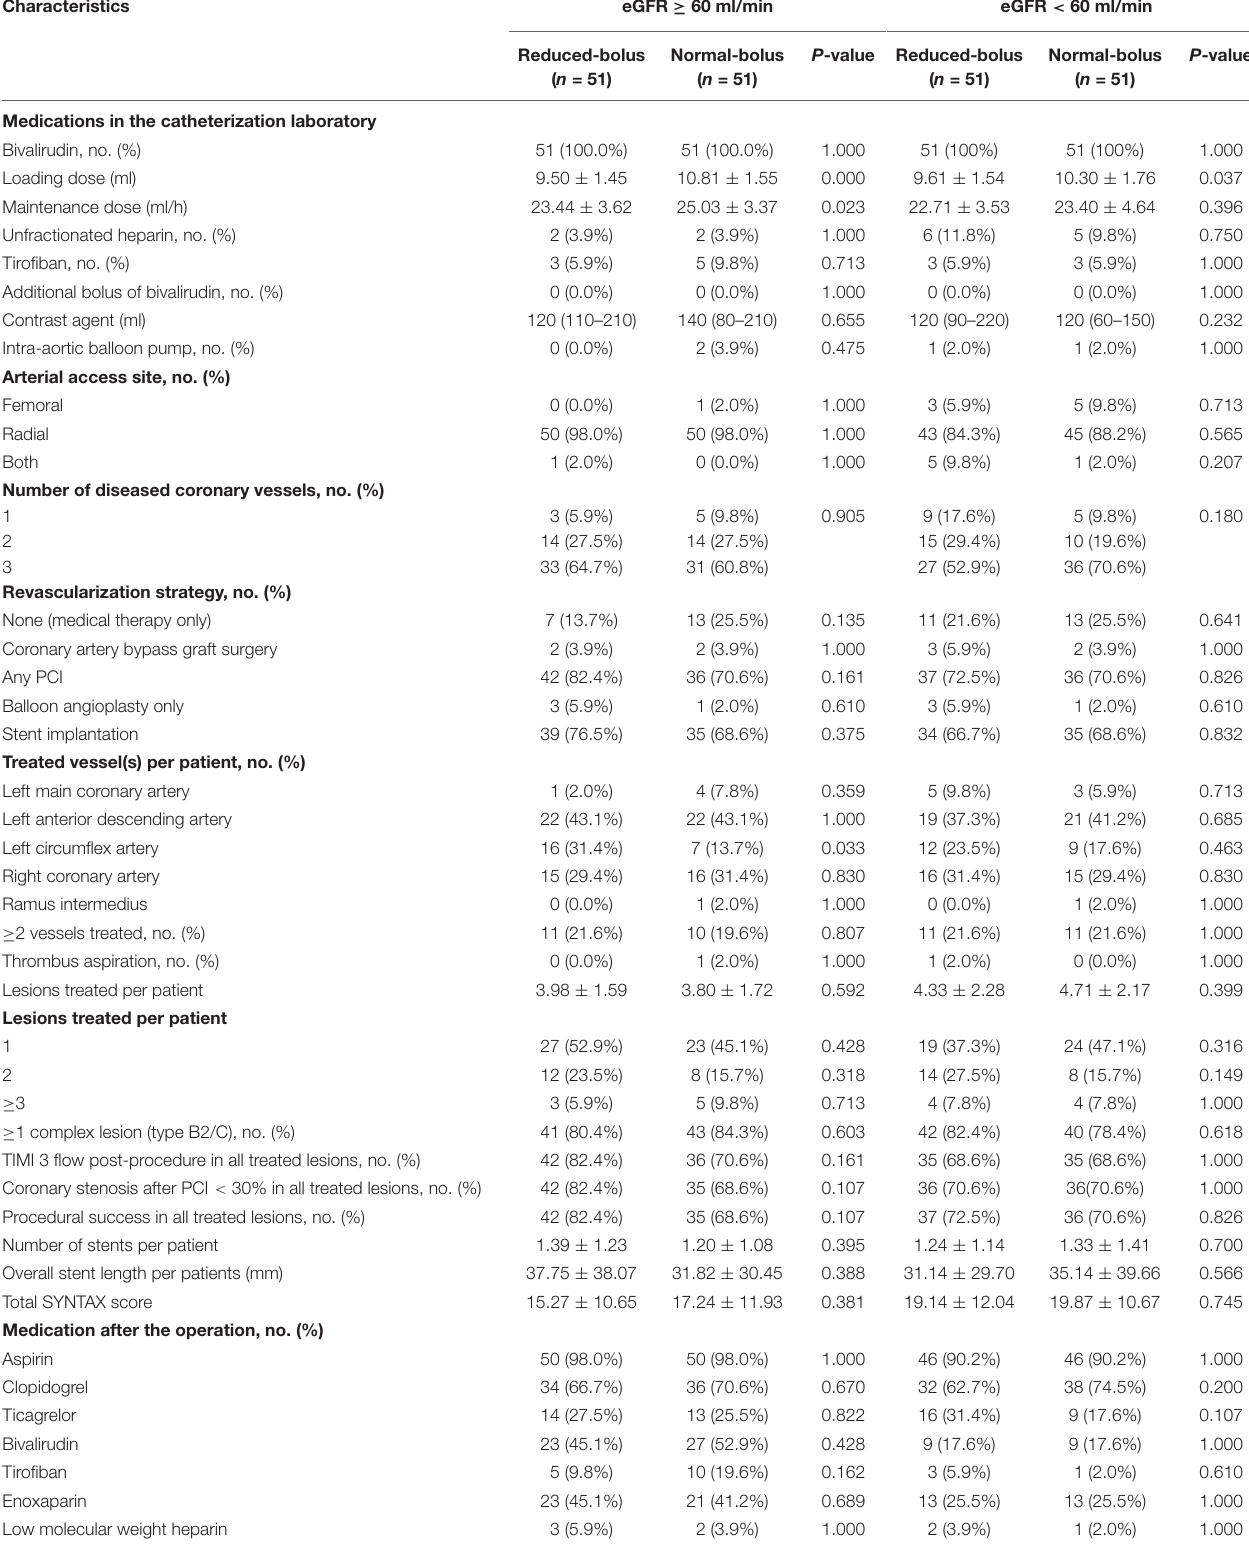
TABLE 3 | Angiographic patient-based procedural